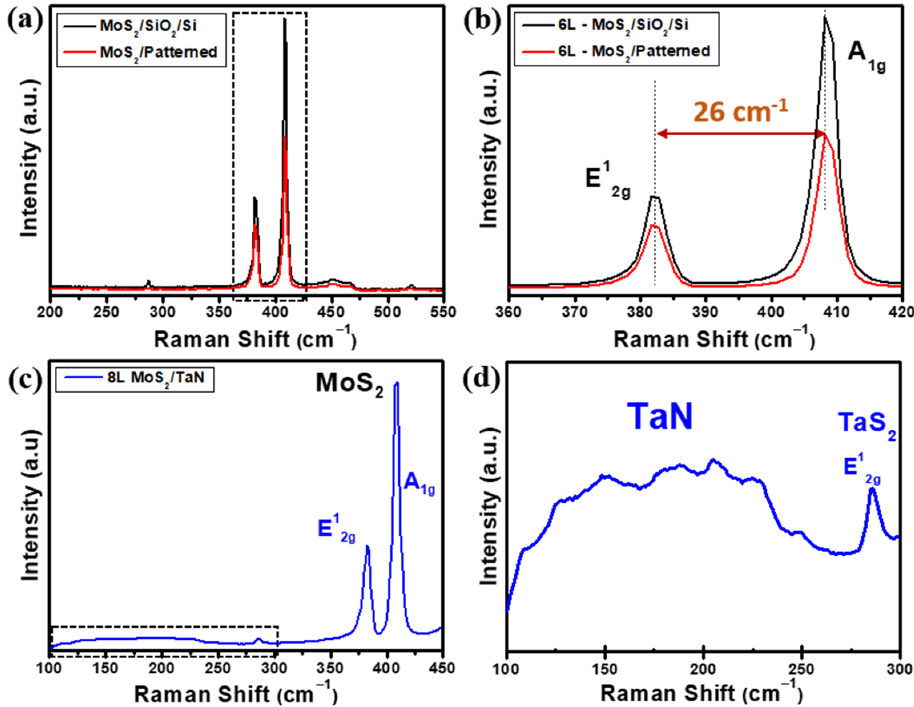
Figure 4. ( a ) Raman spectra obtained on vertically aligned MoS 2 on pre-patterned (red) and equivalent thick flat (black) SiO 2 /Si substrate, ( b ) magnified Raman spectra of panel ( a ) evidencing E 12g (in-plane), A 1g (out of plane) phonon modes of MoS 2 and their frequency difference. ( c ) Raman spectrum of vertical aligned MoS 2 on TaN substrate and ( d ) magnification of Raman spectrum in panel ( c ) in the low Raman shift region (dashed box in ( c )), where the presence of co-deposited TaS 2 peak is evidenced by its E 12g (in-plane) phonon mode.